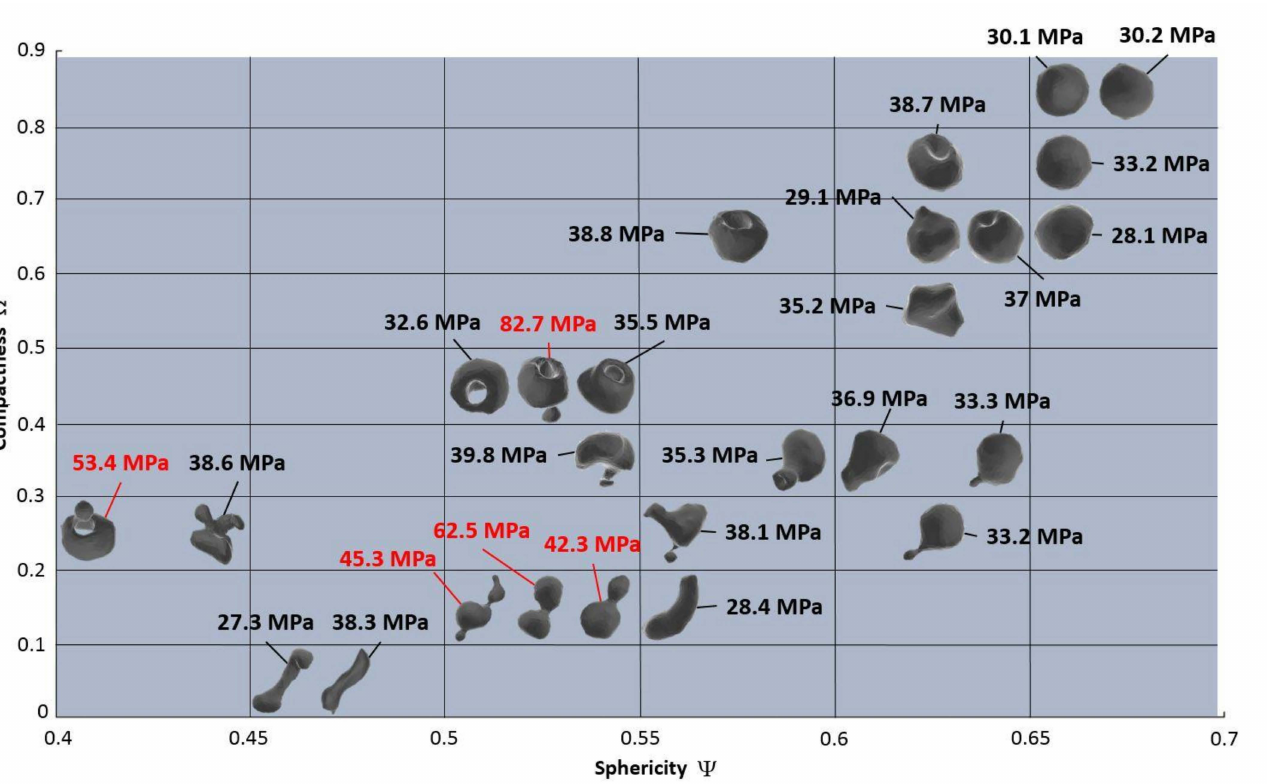
Figure 9. Overview of all 26 extracted and analysed pores from the X-ray scan in relation to their sphericity, compactness, and stress